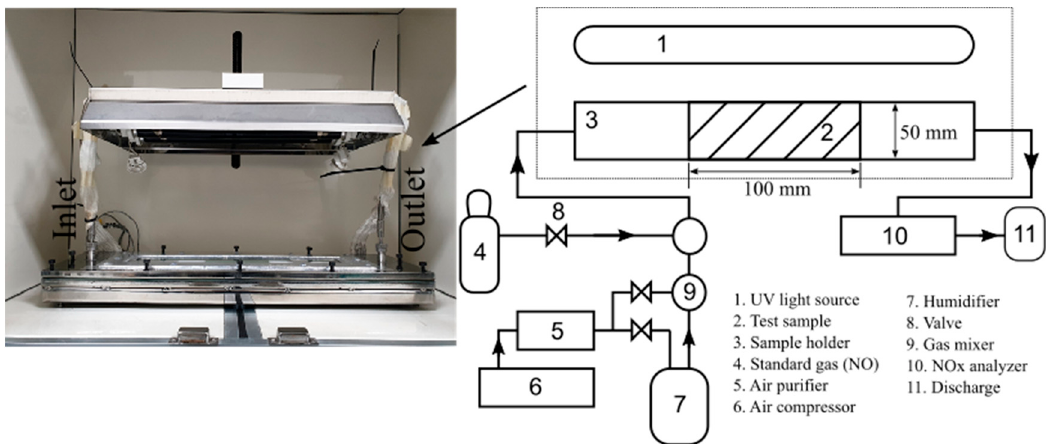
Figure 9. Experimental setup for the photocatalytic decomposition of NOx.